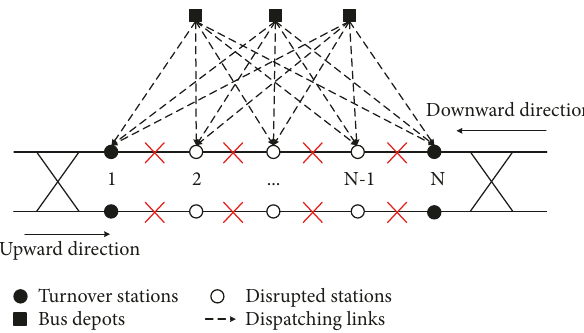
Figure 1: Disruption scenario.